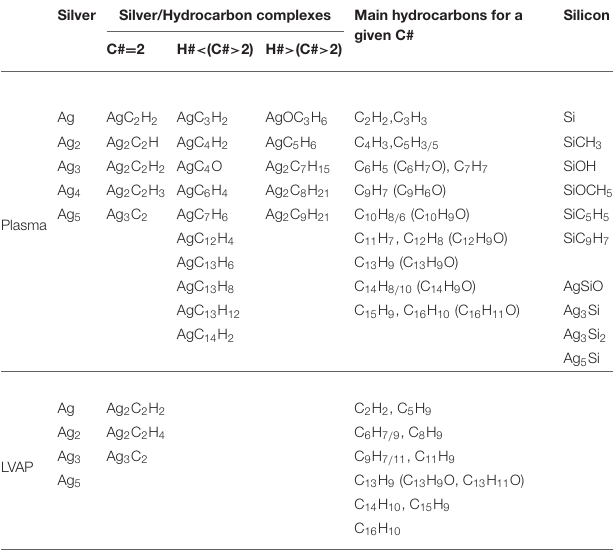
Figure 6 compiles information on the relative contribution in summed ion intensities of Ag-bearing species and hydrocarbons